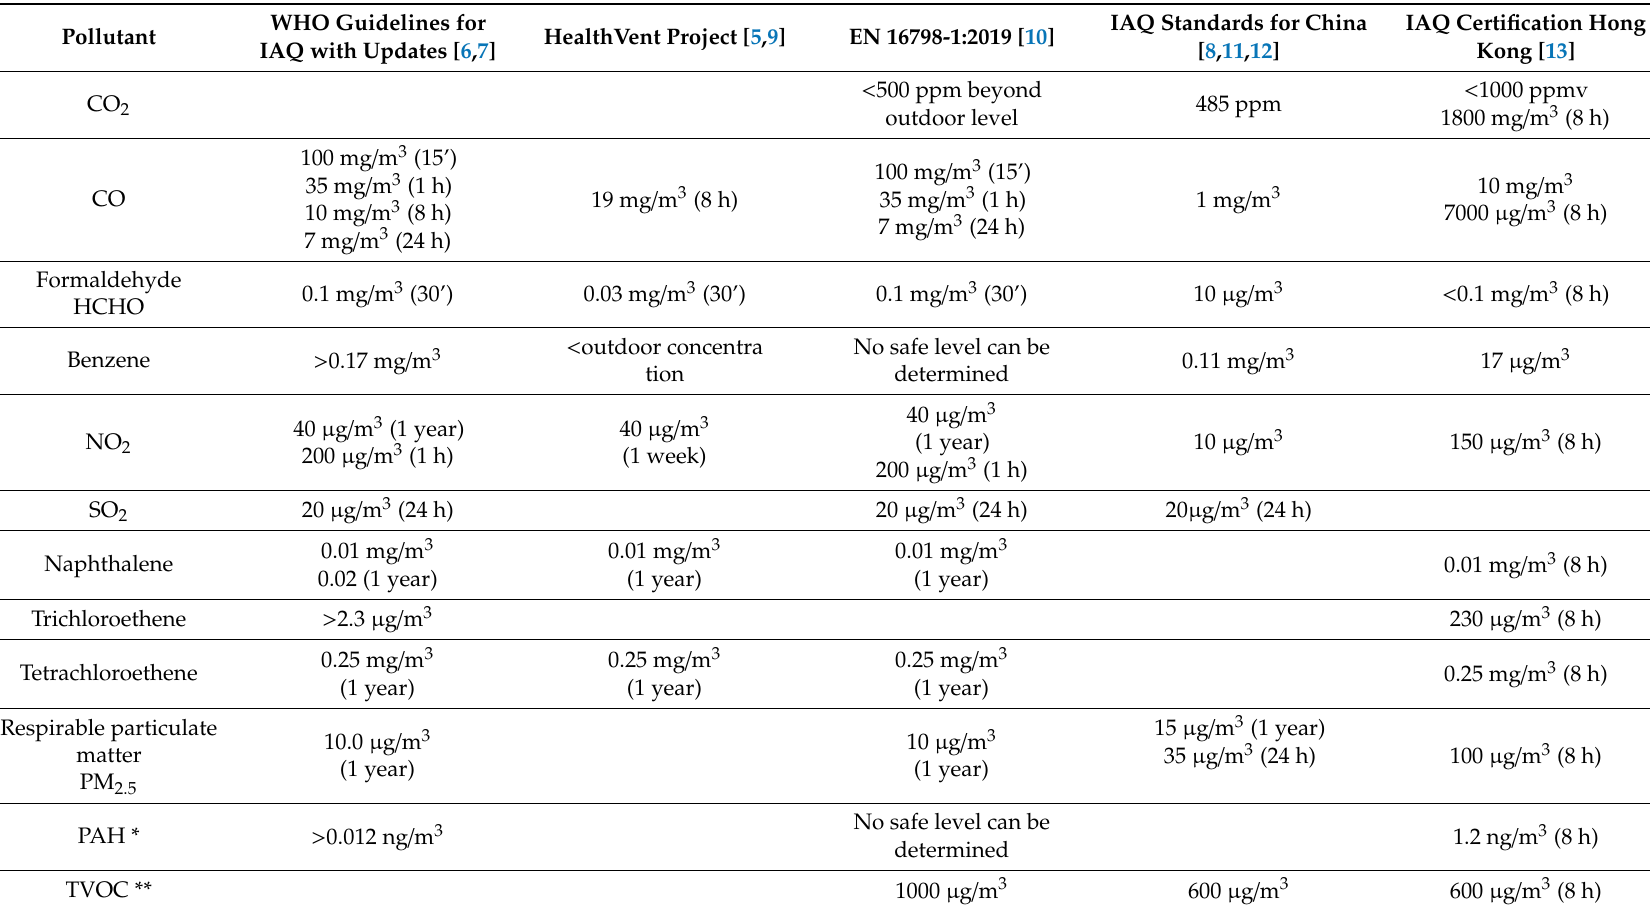
Table 1. Acceptable levels of pollutant concentrations occurring in indoor air, according to World Health Organization (WHO) recommendations supported by the results of the EU research program HealthVent, values recommended by the standard EN 16798-1:2019 (replacing EN 15251:2007), values recommended by the Chinese indoor air quality (IAQ) standard GB / T 18883-2002 and for acceptable levels of pollution for the certification of o ffi ce buildings in Hong